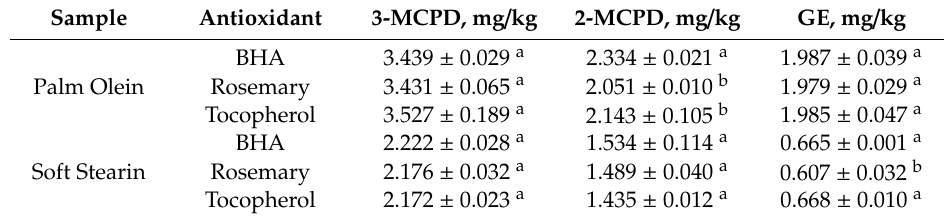
Table 1. E ff ects of di ff erent antioxidants (200 ppm) on the content of 2-monochloropropandiol (MCPD), 3-MCPD and glycidyl ester (GE) on the fats portion extracted from cake baked at 160 ◦ C for 20 min with di ff erent